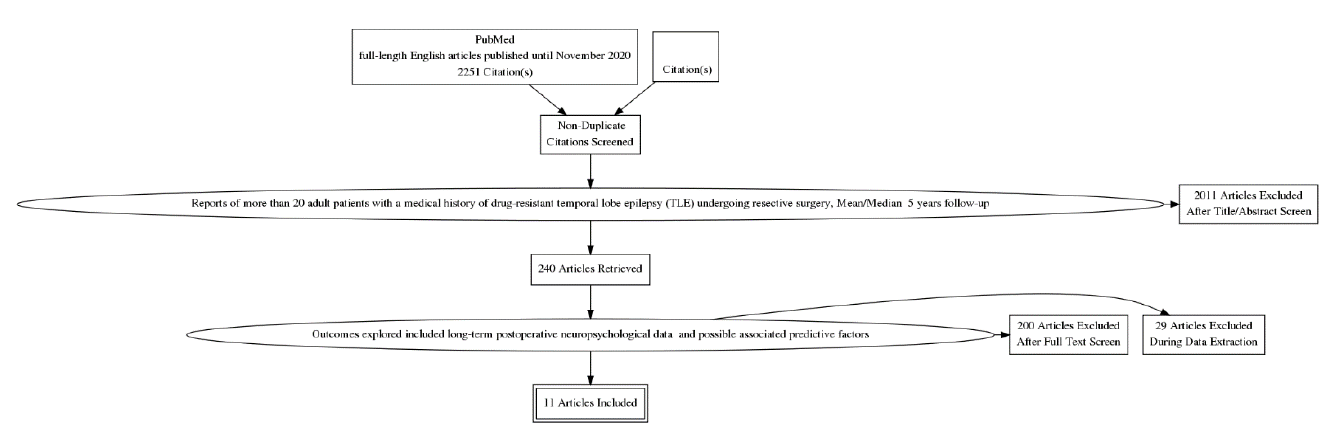
Figure 1. PRISMA flow diagram. The flow diagram depicts the flow of information through the different phases of a systematic review.